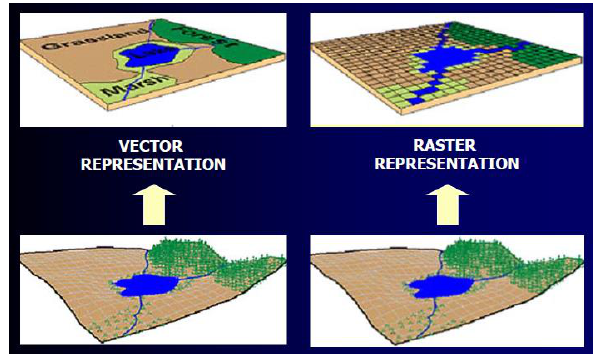
Figure 2. Vector and raster data type as presentation of real world features / map. (Pramoda Raj, 2017)